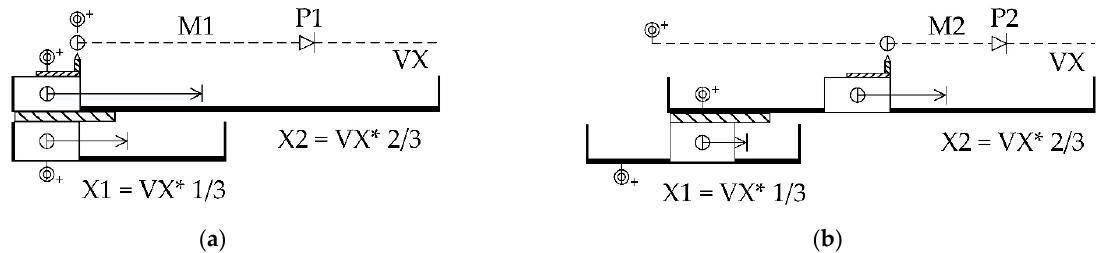
Figure 19. MMCS model of the telescopic servo axis. ( a ) Both carriages at zero position before executing M1 movement; ( b ) representation of movement M2 from final position of M1.